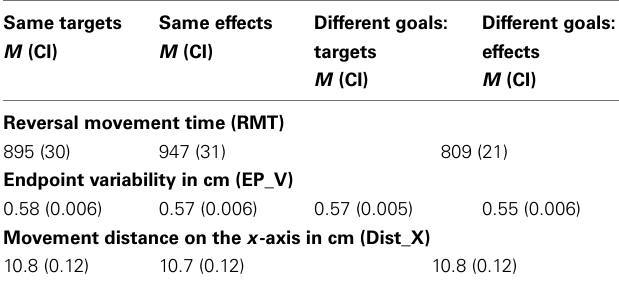
Table 2 | Experiment 2: variables describing temporal and spatial